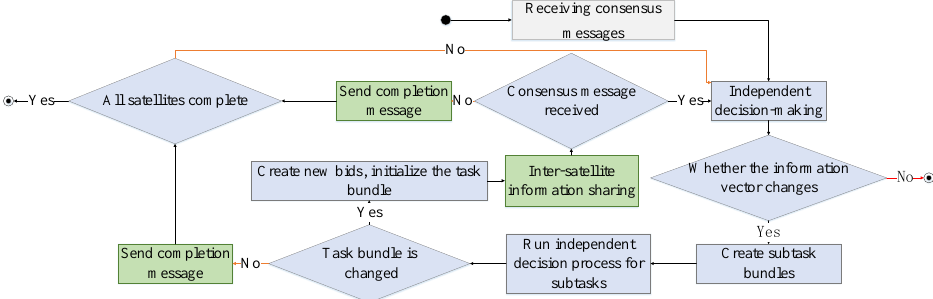
Figure 5. Inter-satellite information-sharing